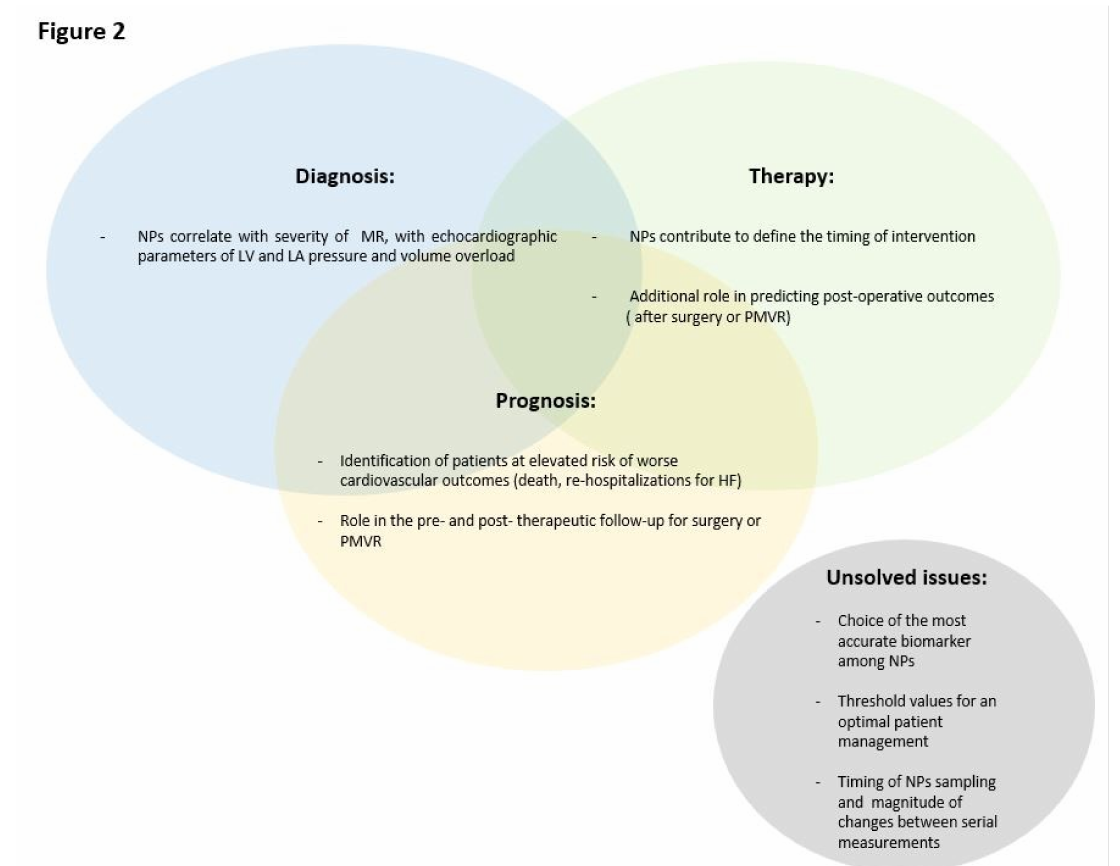
Figure 2. Main clinical implications of NPs in MR. Abbreviation legends: HF = Heart failure; LA = left atrium; LV = left ventricle; NPs = natriuretic peptides; PMVR = percutaneous mitral valve